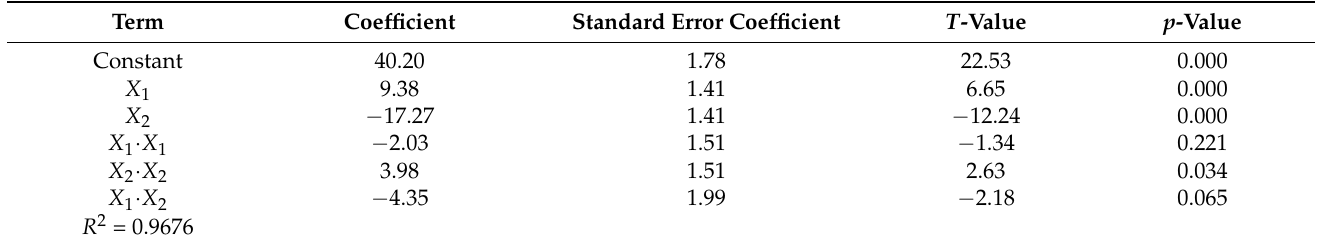
Table 4. The response surface regression coefficients of the polynomial function for the α -tocopherol